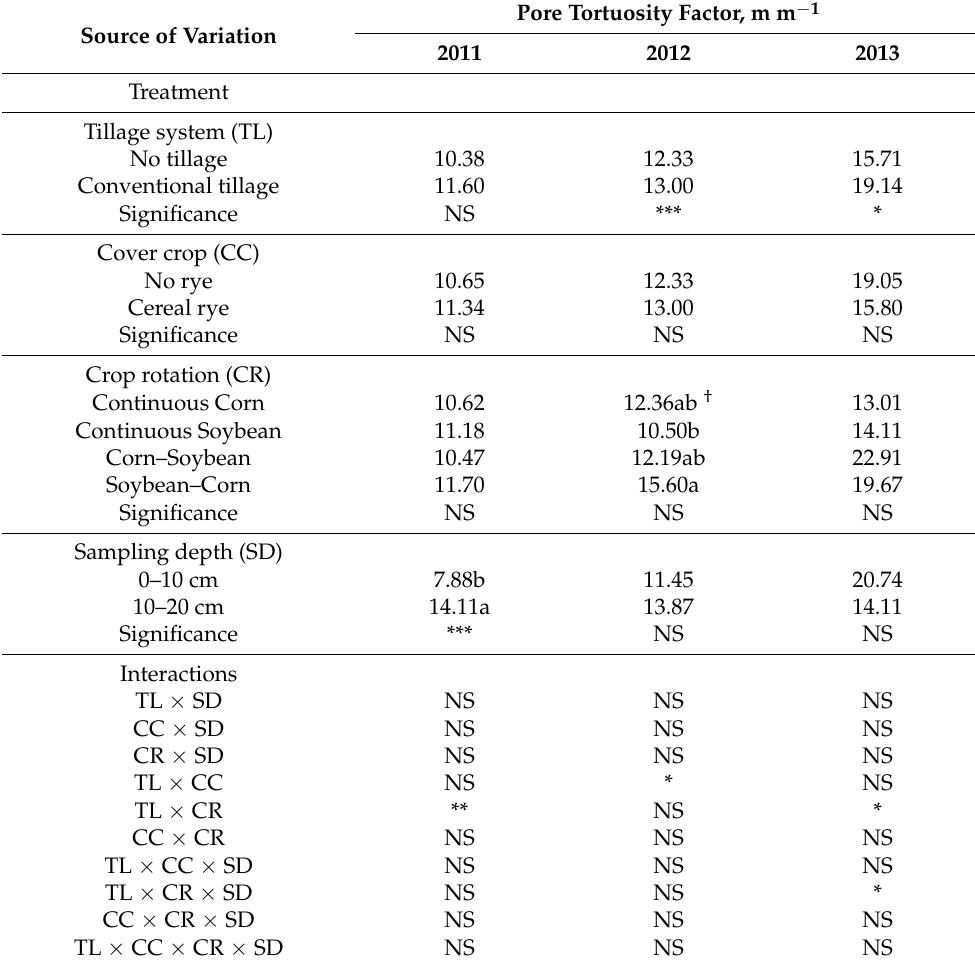
Table 3. ANOVA results with means for pore tortuosity factor as affected by tillage system, cover crop, crop rotation and sampling depth and their